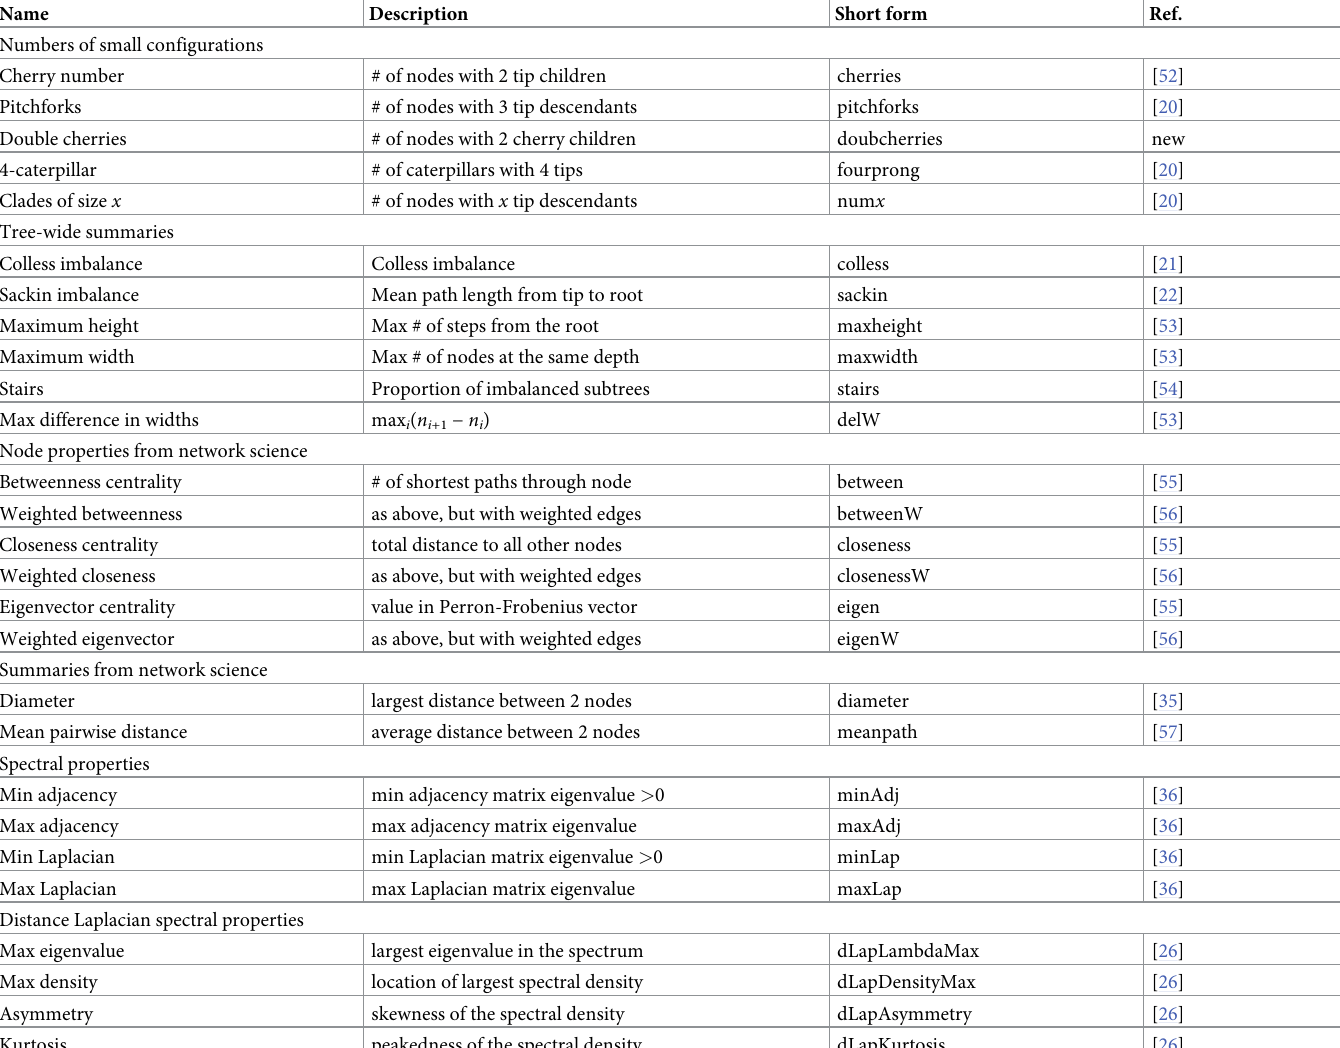
is the number of nodes at depth i i